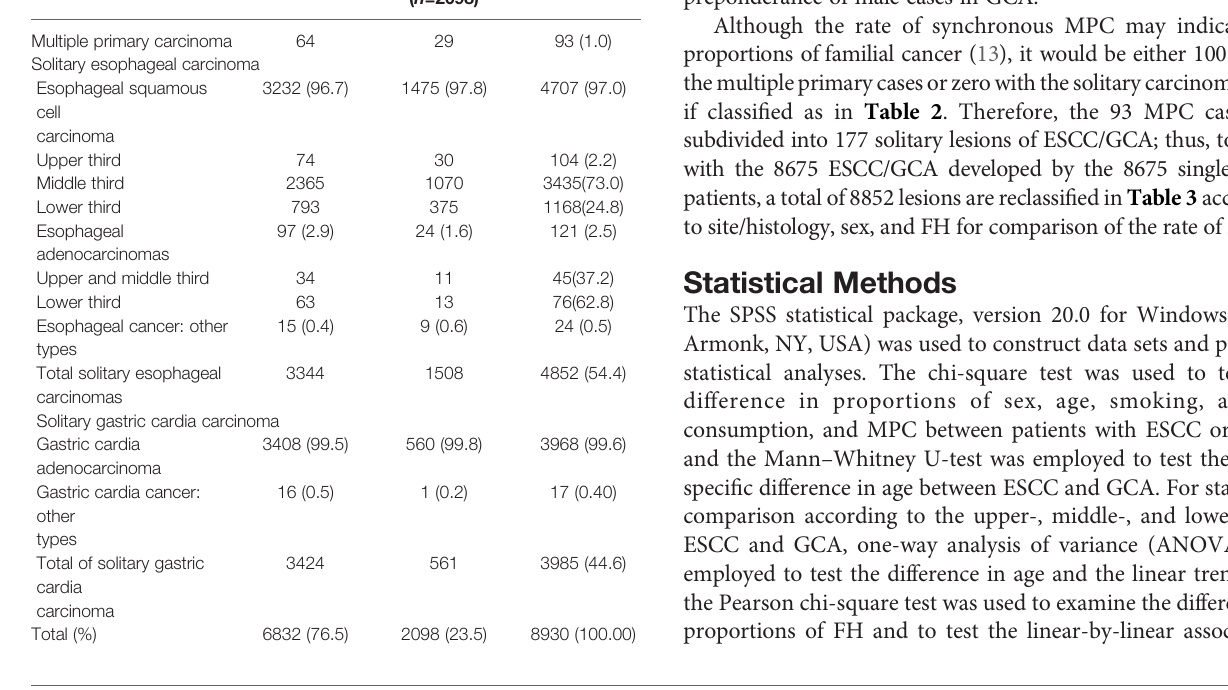
TABLE 1 | Topography and histology of 8930 surgically treated esophageal and/or gastric cardia carcinoma cases at a high-volume center. Site and histology